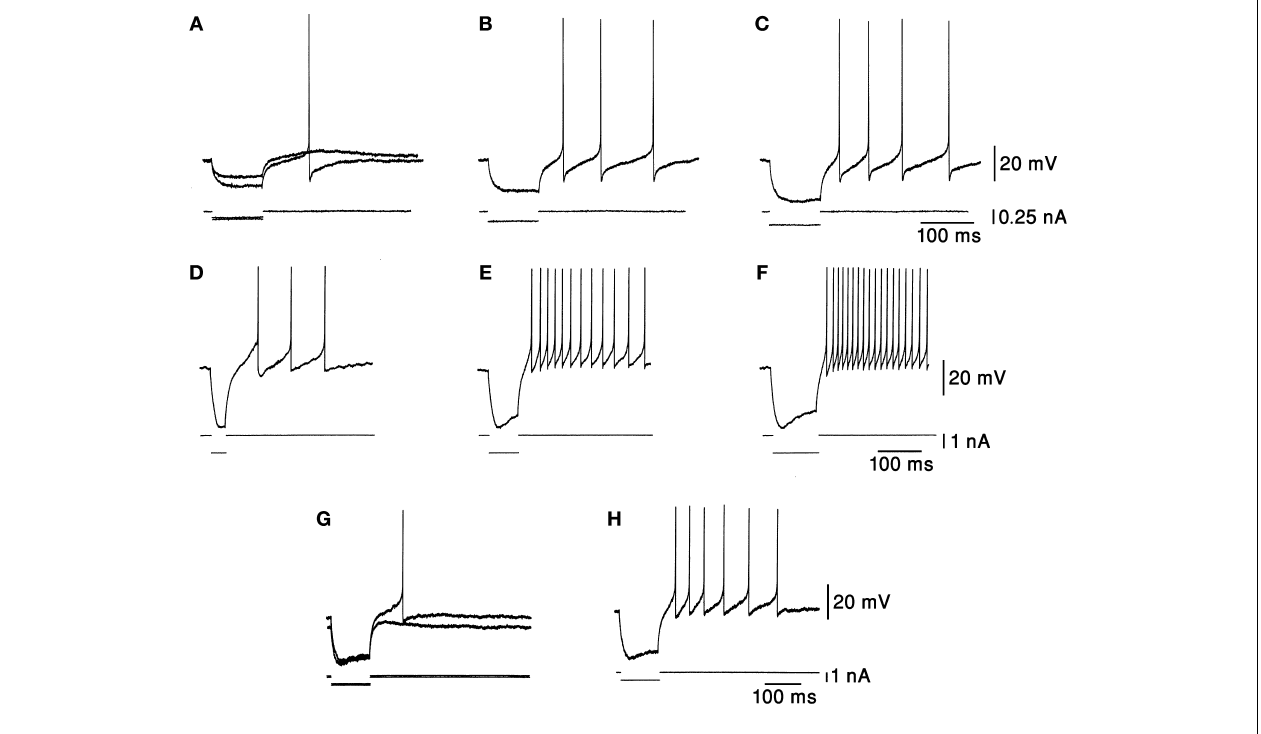
responses were dependent on the duration of preceding hyperpolarization. More spikes were seen after long hyperpolarizations. (G,H) The rebound response was dependent on the initial membrane potential. The response was larger when the membrane was depolarized. Taken with permission from Jahnsen